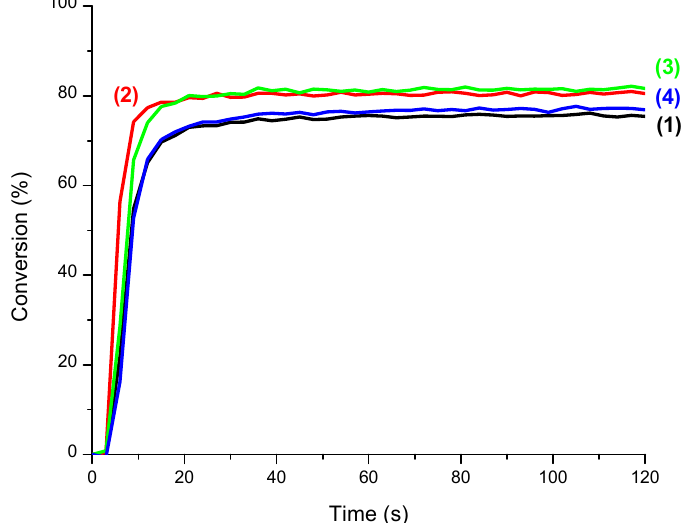
Figure 3. Photopolymerization profiles (methacrylate function conversion vs. irradiation time) for Spectrum ® TPH ® 3 resin (under air; 1.4 mm thick films) upon exposure to the LED@477 nm (I 0 = 300 mW · cm − 2 ) using di ff erent photoinitiating systems. (1) CQ / ethyl-4-(dimethylamino)benzoate (EDB) (0.2 / 0.5 % w / w ); (2) CQ / EDB / SC938 (0.2 / 0.5 / 1 % w / w ); (3) CQ / EDB / S5 (0.2 / 0.5 / 1 % w / w ); (4) CQ / EDB / S6 (0.2 / 0.5 / 1 % w / w ). The irradiation starts for t = 5s.